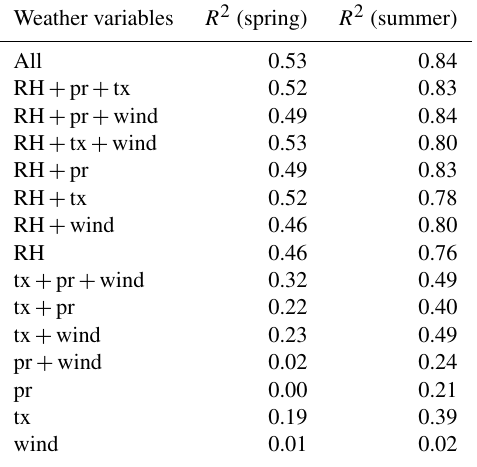
Table A1. Multiple R 2 values for linear models explaining changes in the percentage of days with high fire danger by ensemble mem- ber, country and future period with changes in different combina- tions of the weather variables mean relative humidity (RH), precip- itation amount (pr), daily maximum temperature (tx) and surface wind speed (wind) in spring and